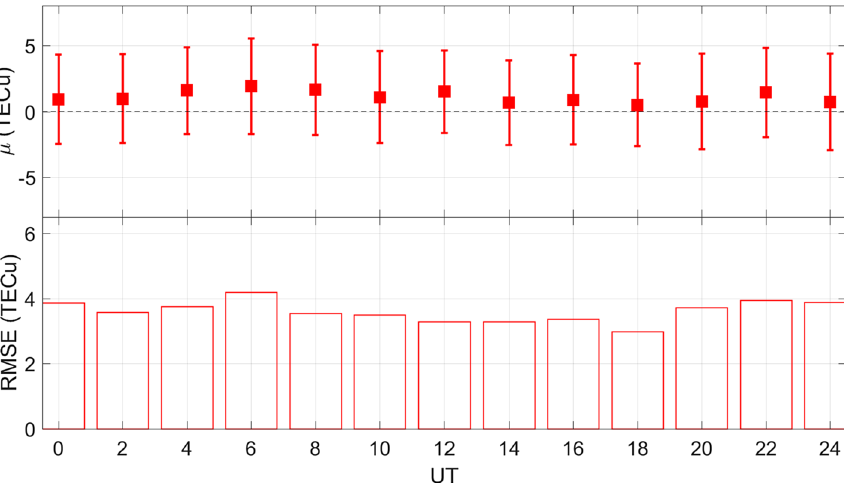
Fig. 17. Hourly dependence of bias (red square, top panel), standard deviation (error bars, top panel) and RMSE (bottom panel) of vTEC from JASON-3 vs. vTEC from